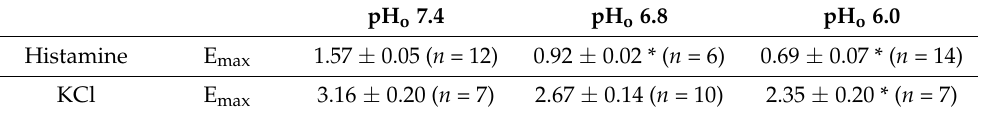
Table 1. Histamine- (1 nM–100 µ M) and KCl (20–80 mM)-induced contractile response at pH o 7.4, 6.8, and 6.0 in SMA rings. Data were expressed as mean gram tension ± SE. n = no of experiments.